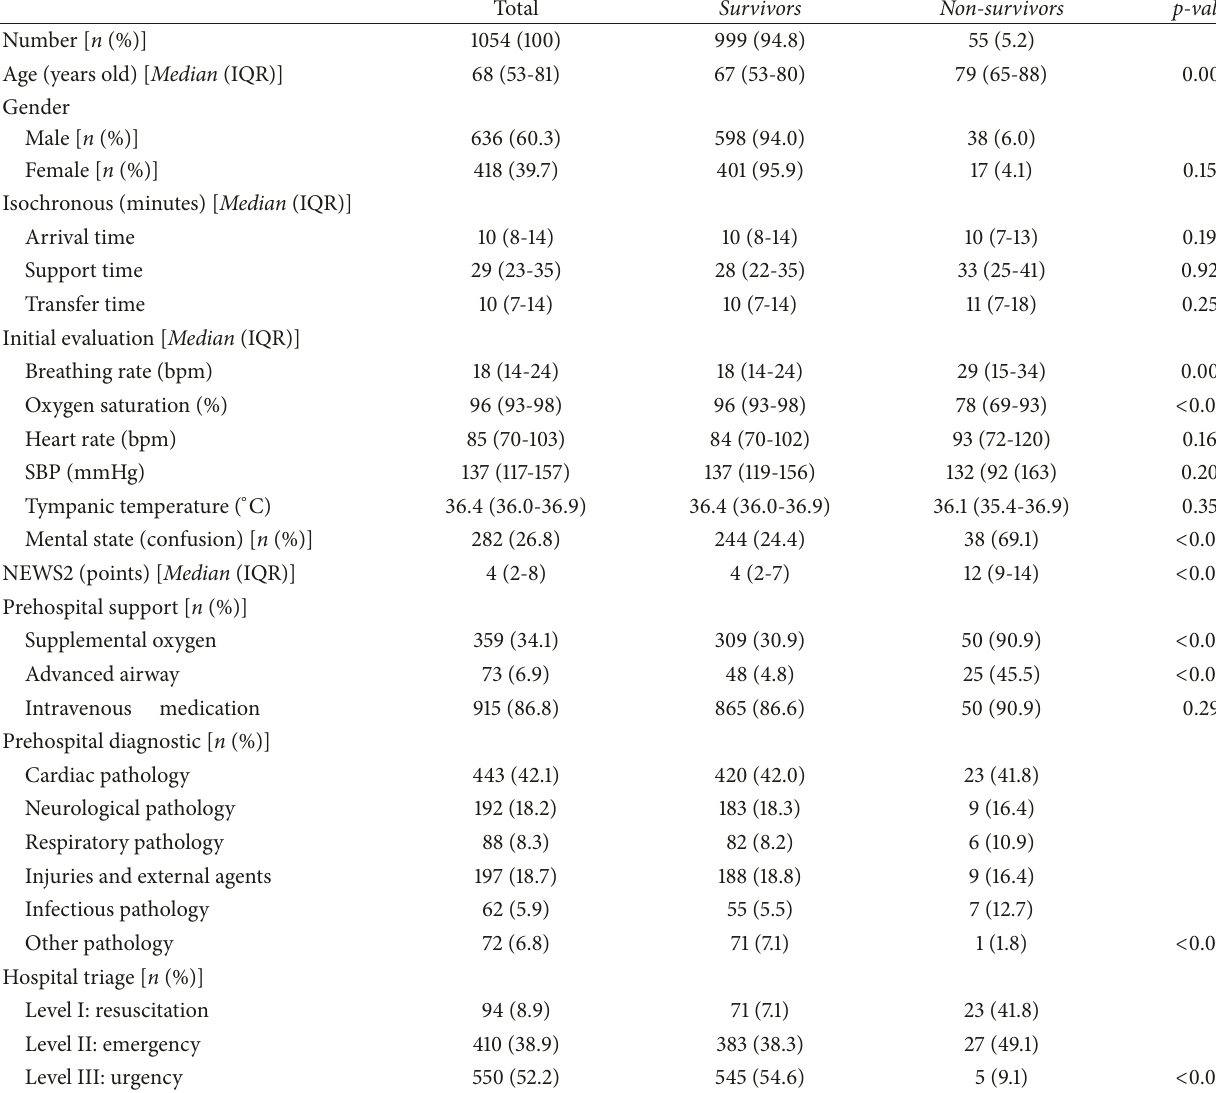
Table 1: General patient characteristics (death statistics refer to early mortality